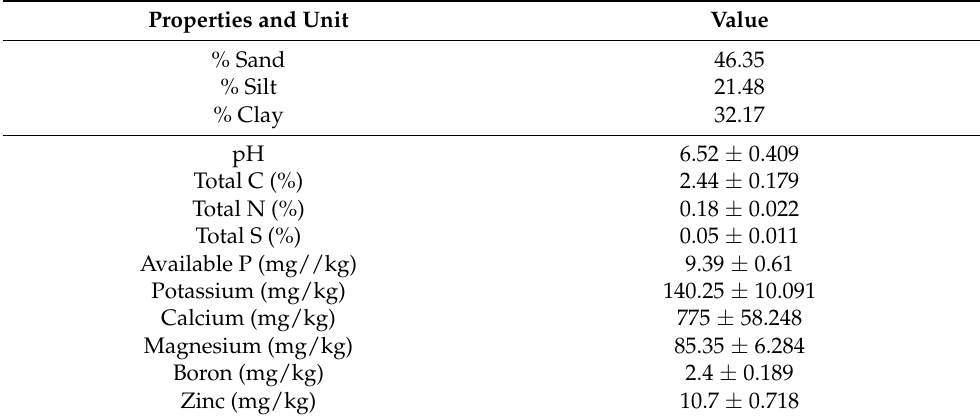
Table 1. Initial soil physical and chemical properties of the experimental